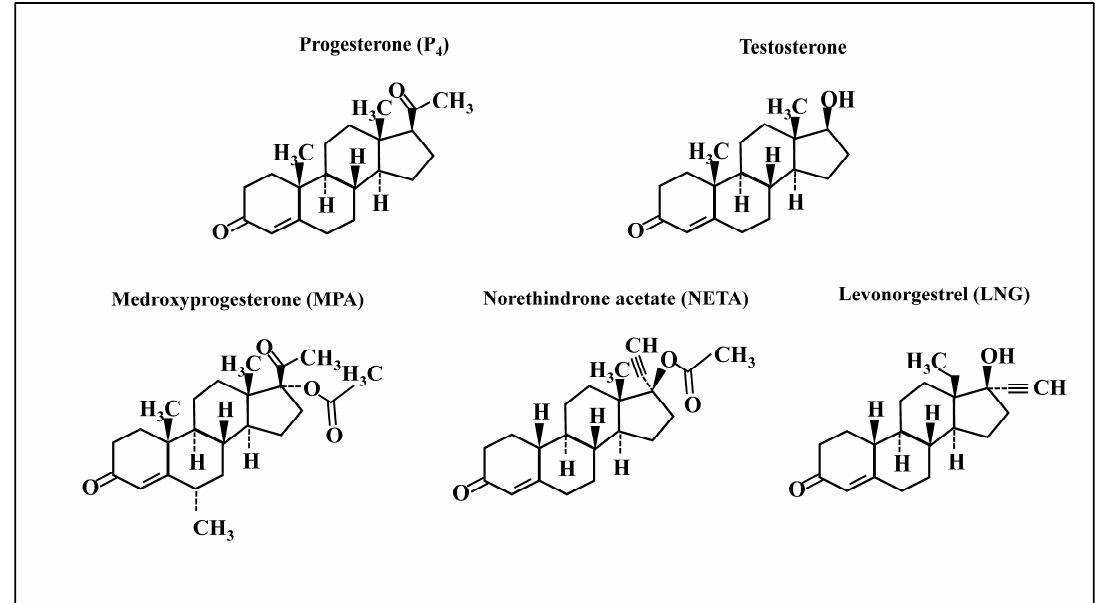
Figure 1. Chemical structures of progestins used in the study. Chemical structures of progesterone, testosterone, medroxyprogesterone acetate (MPA, a progestin structurally related to progesterone), and two progestins structurally related to testosterone: norethindrone acetate (NETA) and levonorgestrel (LNG).